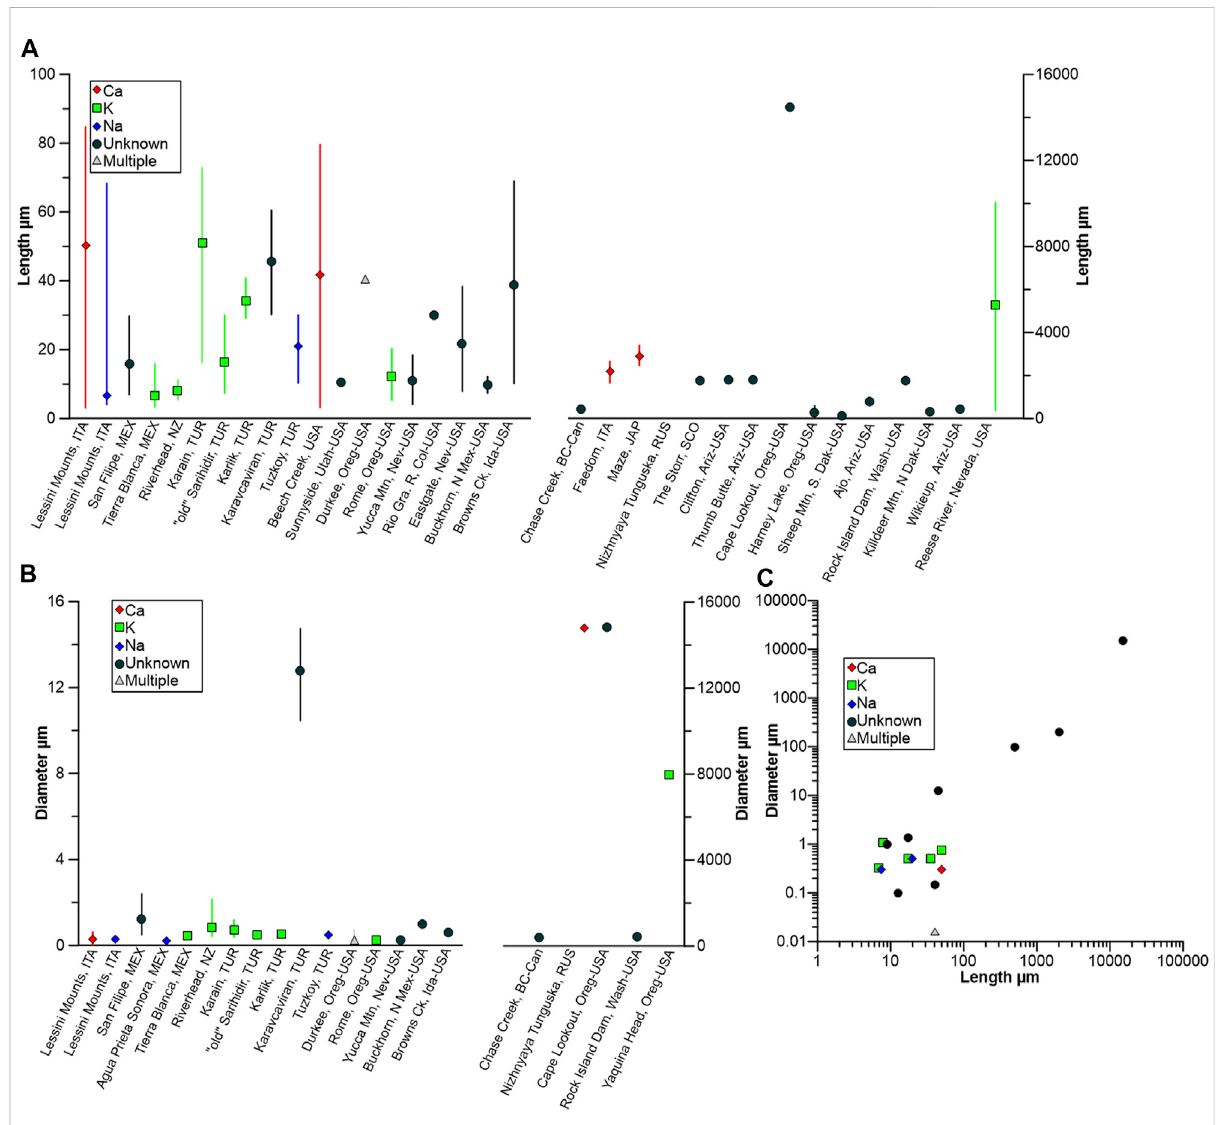
FIGURE 7 Morphometric data for erionite, coded by erionite species, where data is available: (A) Length of erionite fi bers and location, with mean and value range (note different y -axes); (B) diameter of erionite and location, with mean and value range (note different y -axes); (C) scatterplot of length vs. diameter, coded by erionite